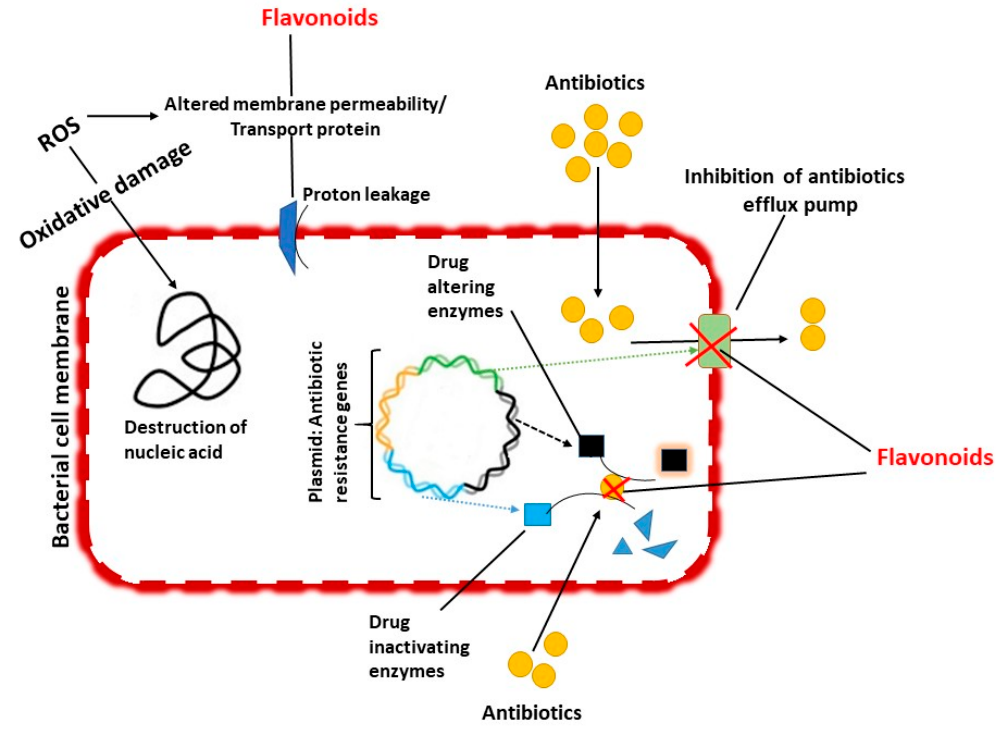
Figure 3. Mechanism of antimycobacterial activity of flavonoids.